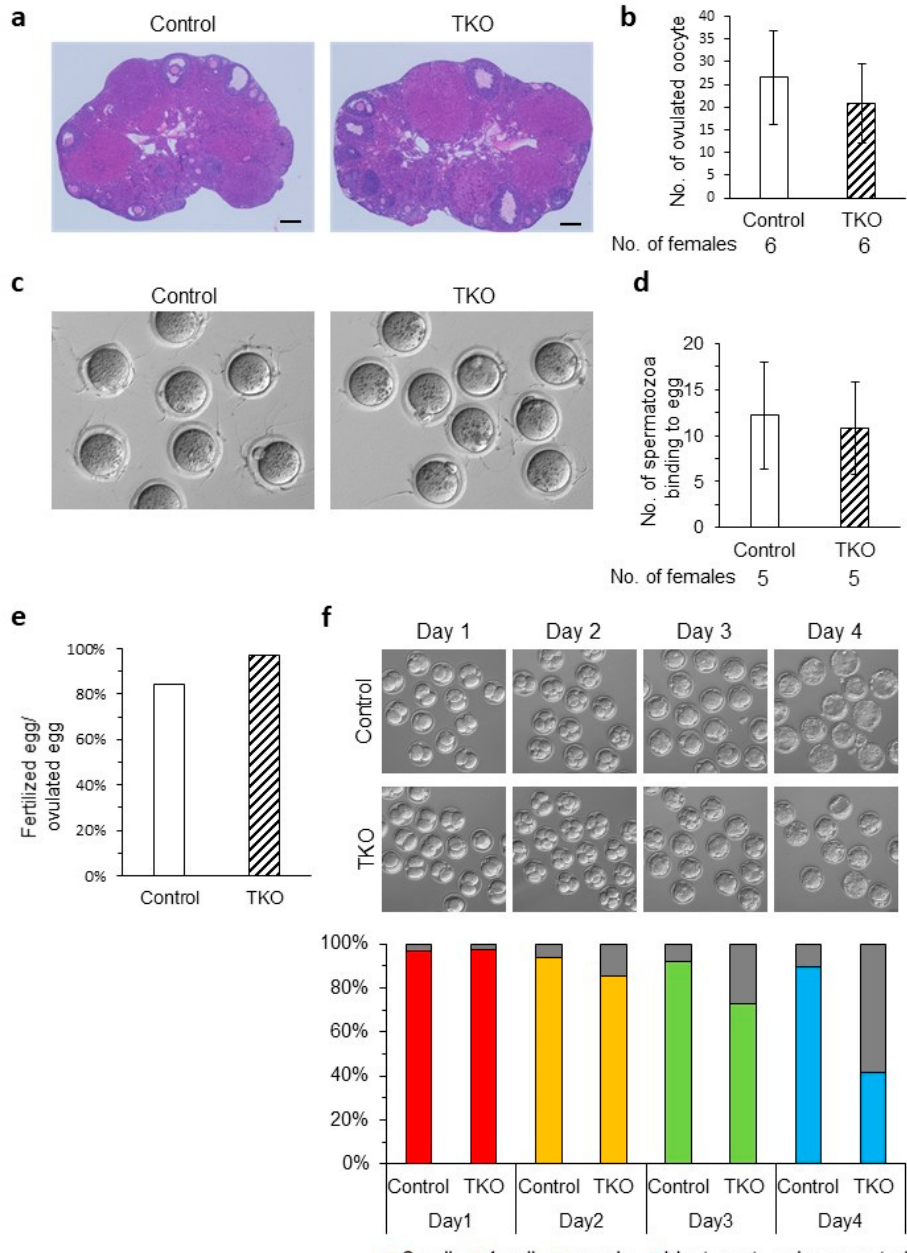
Figure 4. Phenotypic analysis of Oosp family KO females. ( a ) Histological analysis of ovaries in Oosp heterozygous KO (Control) and homozygous KO (TKO) mice. Scale bars = 200 µm. ( b ) Average number of oocytes ovulated by a hormone primed female. Four-week-old females were examined ( n = 6). ( c ) Sperm ZP-binding assay. Spermatozoa were inseminated with control and KO oocytes from which cumulus were removed. ( d ) Average number of spermatozoa bound to ZP. Three-week-old to 14-week-old females were used. ( n = 5) ( e ) Average fertilizing ratio: 133 heterozygous and 106 TKO oocytes were examined. ( n = 5) ( f ) Developmental ratio of embryos after in vitro fertilization. Superovulated oocytes from control and TKO females were examined. Two-cell embryos, four-cell embryos, morulas, and blastocysts were observed at 24 h (Day1), 48 h (Day2), 72 h (Day3) and 96 h (Day4) after insemination. One hundred twelve and 103 eggs ovulated by four-week-old to 10-week-old heterozygous and TKO females were examined, respectively ( n = 5, p <